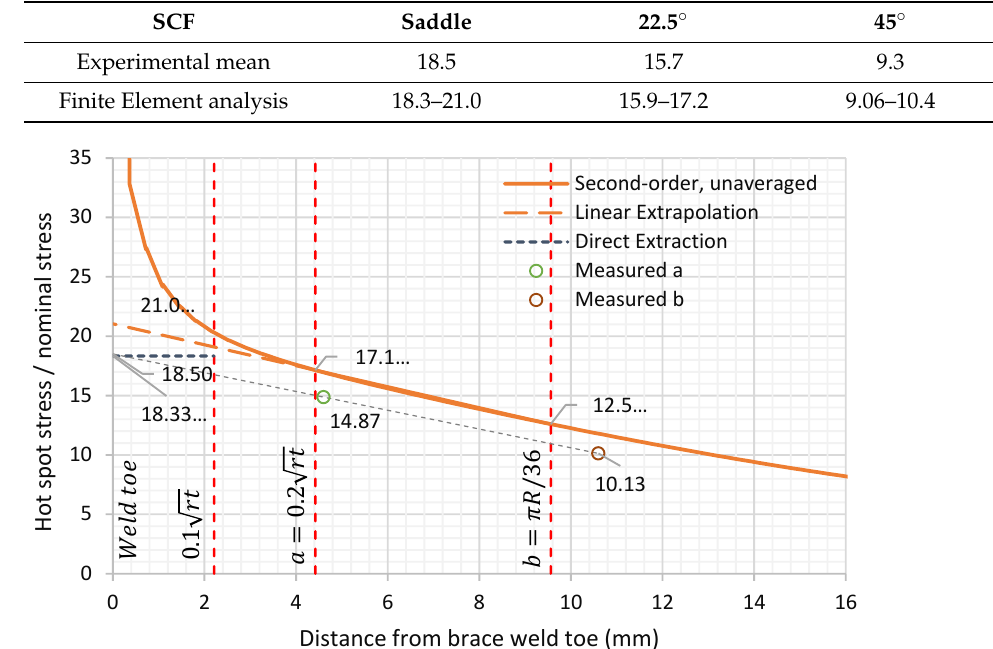
Figure 18. SCF based FEA compared to SCF from specimen DT 1 — quadrant 3.